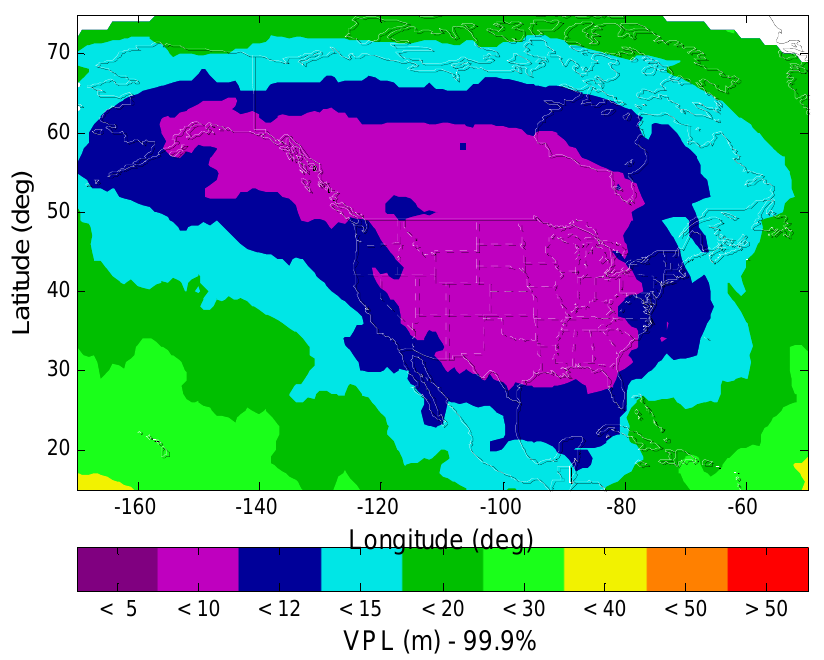
Figure 11. The 99.9% VPL contour of the dual-mode (GPS + Galileo) and L1-L5 dual-frequency WAAS user avionics sensor. The VPL values in most of CONUS, Alaska, and Canada are less than 12 m (CAT I VAL). Importantly, The VPL values are less than 10 m in most of CONUS and